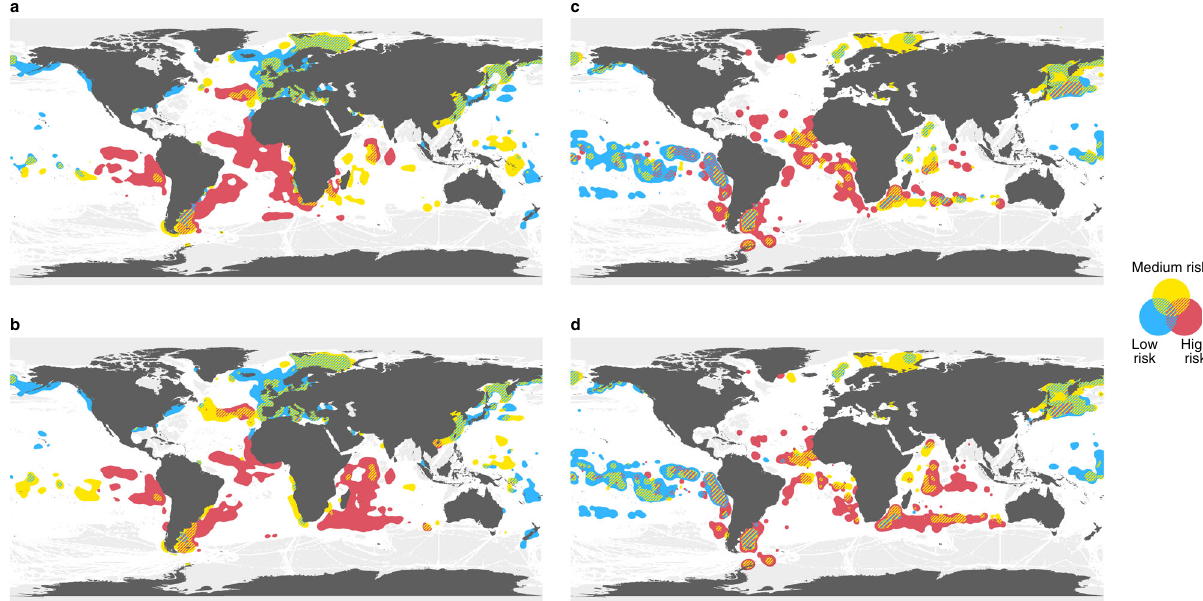
Fig. 2 Risk maps for labor abuse and IUU fi shing and associated with transshipment at sea. At-sea risk areas based on arrival ports for ( a ) labor abuse and ( b ) IUU fi shing, and transshipment risk areas for ( c ) labor abuse and ( d ) IUU fi shing. Low-, medium- and high-risk areas are colored in blue, yellow, and red respectively, and overlaps between risk categories are hashed. At-sea areas in white indicate less risk than the colored areas, rather than zero risk. Gray at-sea regions indicate lack of AIS data. For at-sea and transshipment risk areas, each fi shing or carrier trip risk score of the arrival port was classi fi ed into low-risk (port risk score < 0), medium-risk (0 ≤ port risk score < 2) and high-risk (port risk score ≥ 2), with ( a , b ) illustrating areas greater than 95% quantile of fi shing cumulative hours by all fi shing vessels, and ( c , d ) areas greater than 95% quantile of encounter events between carrier vessels and fi shing vessels in 2012 – 2019 for each risk category. For ( a , b ), root-mean-square error (RMSE) of cross-validation was 0.88 and Matthews Correlation Coef fi cient (MCC) was 0.62 for port risk of labor abuse, and RMSE 0.88 and MCC 0.65 for port risk of IUU fi shing. For ( c , d ), RMSE = 1.14 and MCC = 0.49 on port risk of labor abuse, and RMSE = 1.25 and MCC = 0.45 for port risk of IUU fi shing.